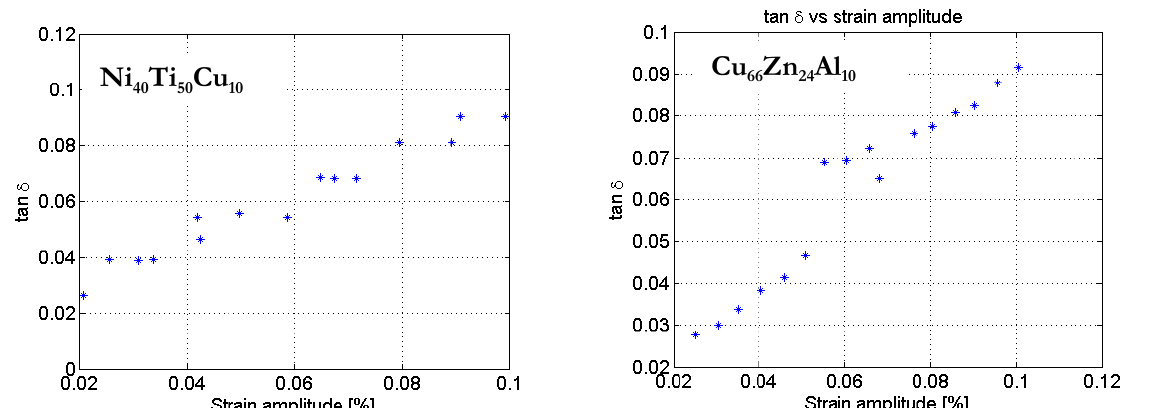
Figure 7: tan δ vs. strain amplitude. Tensile test: f=10 Hz, room temperature.